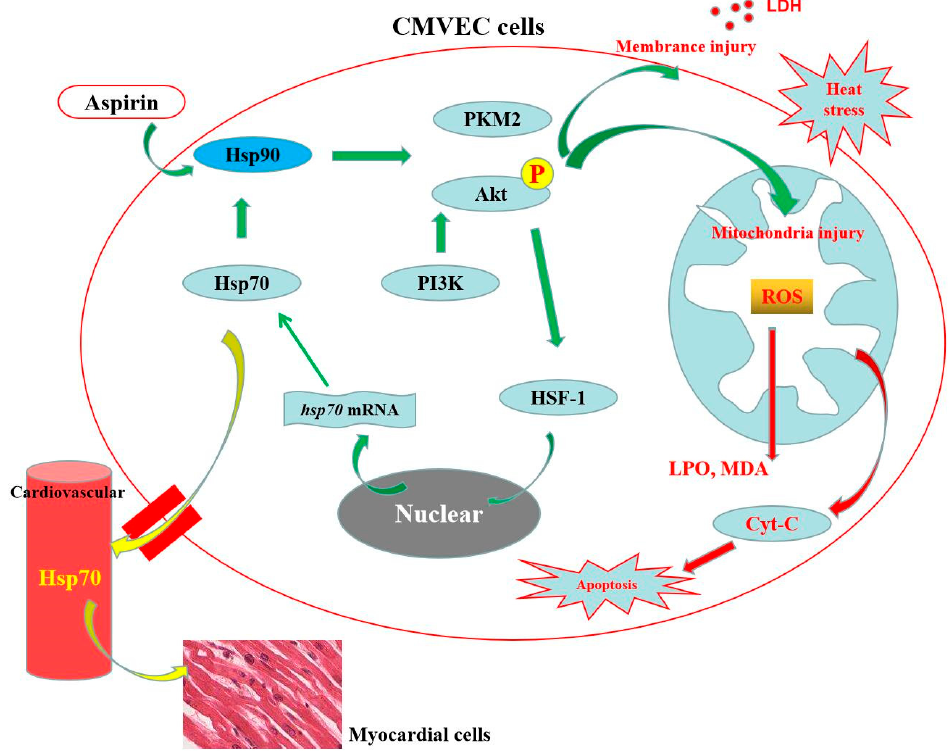
Figure 8. Schematic representation of the Hsp90-mediated resistance to heat stress damage in the heart. Heat stress caused the oxidative stress and cytomembrane damage, thus resulting in apoptosis and necrosis of CMVECs. Hsp90 mediated Akt and PKM2 signals differently through their interaction to inhibit heat stress damage. In addition, Hsp90-mediated Akt activation regulated Hsp70 expression and release via HSF-1 to protect myocardial cells. Aspirin could improve the resistance of CMVECs to heat stress through inducing Hsp90 expression and its promotion of Akt and PKM2 function.